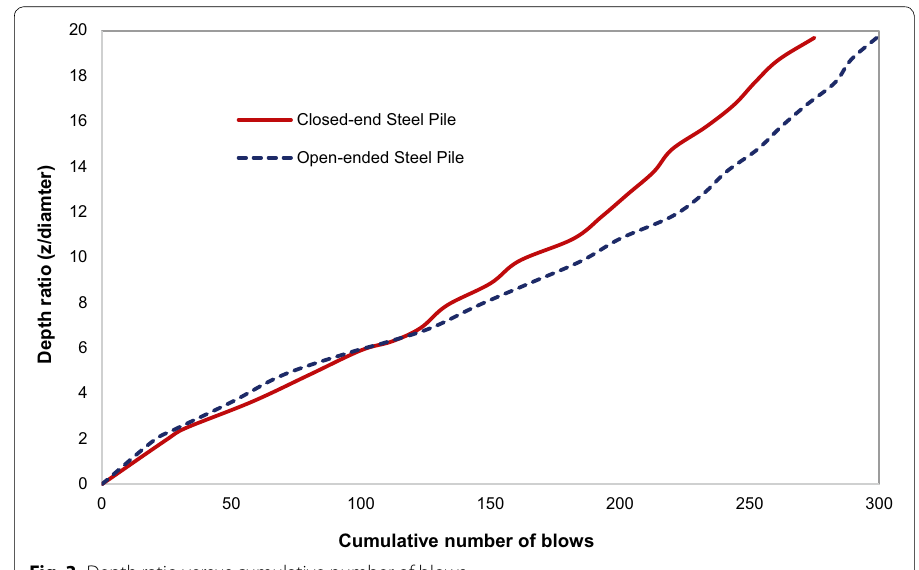
Fig. 3 Depth ratio versus cumulative number of blows